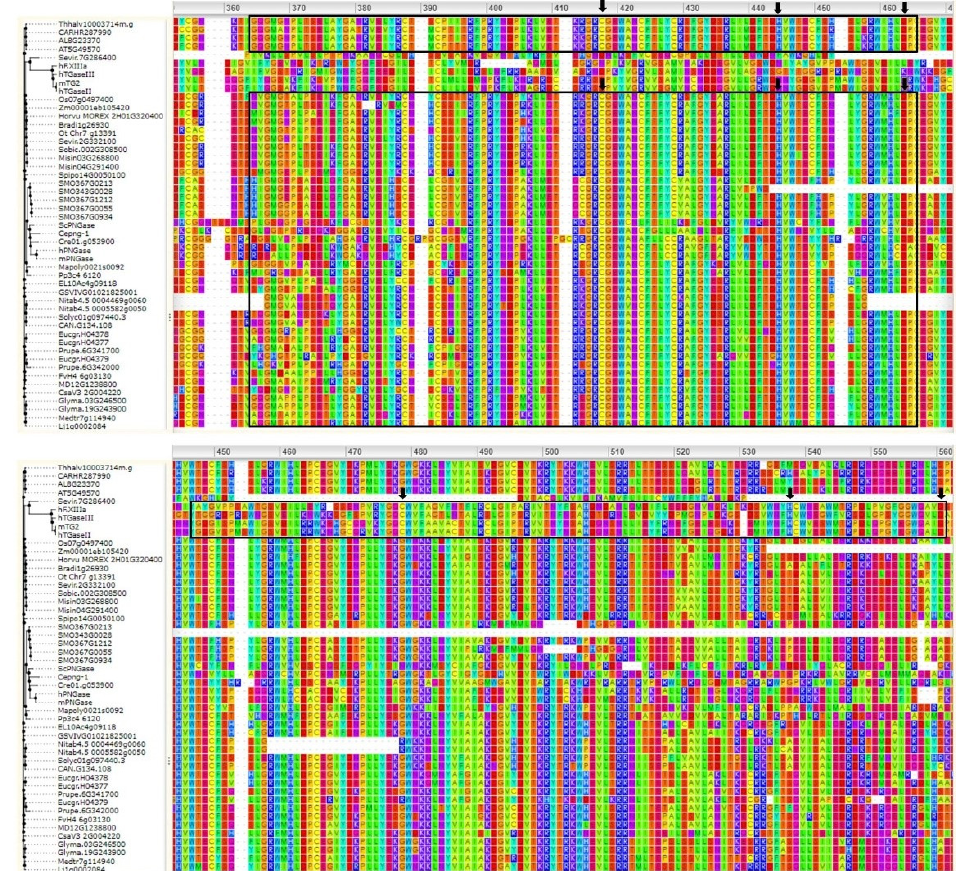
Figure 2. Multiple sequences alignments of transglutaminases and peptide N-glycanases. The protein sequences were aligned using ClustalW, and the ConSurf analysis was performed on the webserver (https://consurf.tau.ac.il/, accessed on 17 March 2022). The sequences in the black boxes show Pfam-PF01841 (Transglut_core). The arrows indicate the Cys–His–Asp amino acids of the catalytic triad. Despite having an amino acid sequence different from those of known animal TGases (Factor XIIIa, hTGaseII, and human TGaseIII), the core domains of the mouse PNGase and that of human TG2 have the same fold, as also reported in the SCOP database (family: transglutaminase core; http://scop.mrc-lmb.cam.ac.uk/scop/data/scop.b.e.d.b.f.html, accessed on 14 March 2022). The protein sequences used here, other than the plants, were: C. elegans (Cepng-1, NP_492913.1), S. cerevisiae (ScPNGase, NP_015229.1), mouse (mPNGase, NP_067479), human (hPNGase, AF250924.2) and mouse (mTG2, NP_033399.1) peptide N-glycanases, human Factor XIIIa (hF.XIIIa, NP_000120), human TGase II (hTGaseII, NP_945189), and human TGase III (hTGaseIII, Q08188)